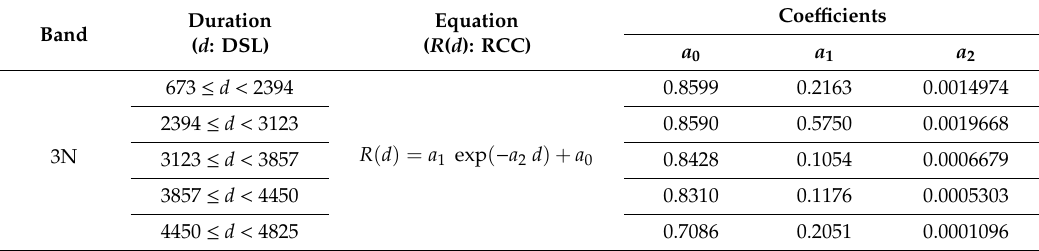
Table 3. Equations and parameters of the current radiometric degradation curves in the radiometric DB ver. 4 for ASTER Band